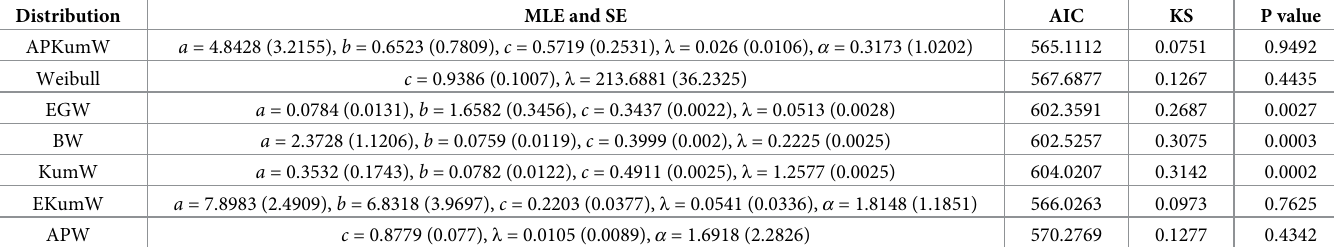
A variety of tools can be applied for comparing different competing distribution for a spe- cific dataset and choosing the best model for the fitting. To investigate the goodness-of-fit for the compared distribution, Akaike Information Criterion (AIC) and Kolmogorov–Smirnov (KS) along with its P value are considered in order to choose the best distribution. The better distribution is which corresponds to the lower values of AIC, KS and highest P value of KS sta- tistic. The plots of the estimated cdf for each of the distributions are compared with the plot of the empirical cdf. Also, the histogram of the observed frequencies is compared with the plots of the expected frequencies for each fitted distribution. The MLEs of the parameters for all the five datasets along with their SEs (in parentheses) and the corresponding goodness-of-fit criteria for all the competing models are respectively presented in Tables 3–7. Additionally, Table 4. MLEs, (SEs) for the parameters and associated goodness of fit statistics for the head and Neck cancer data. Distribution